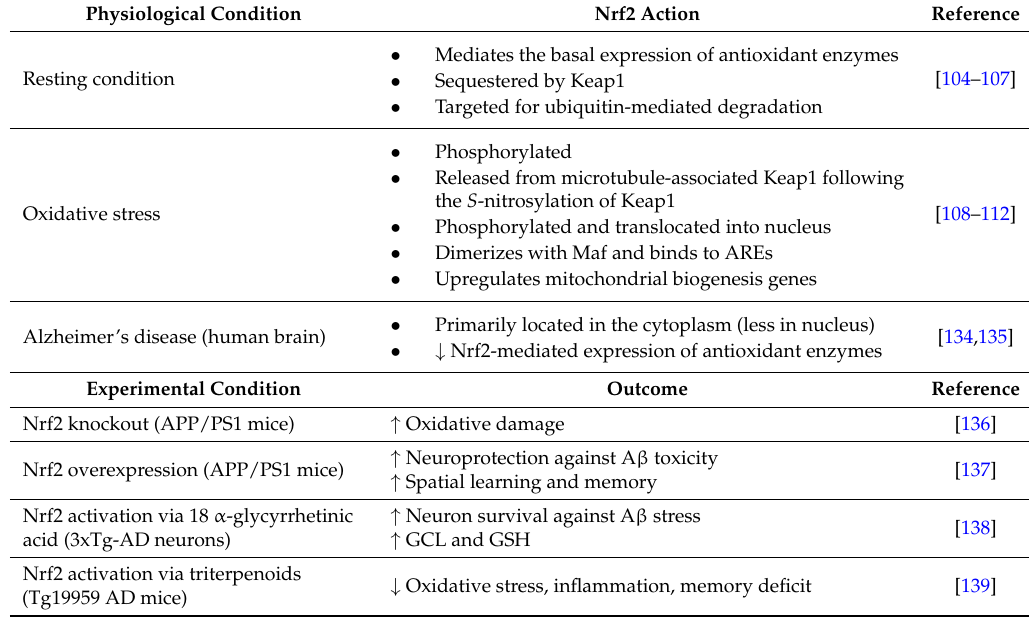
Table 1. Summary of the main findings of Nrf2 in physiological and experimental